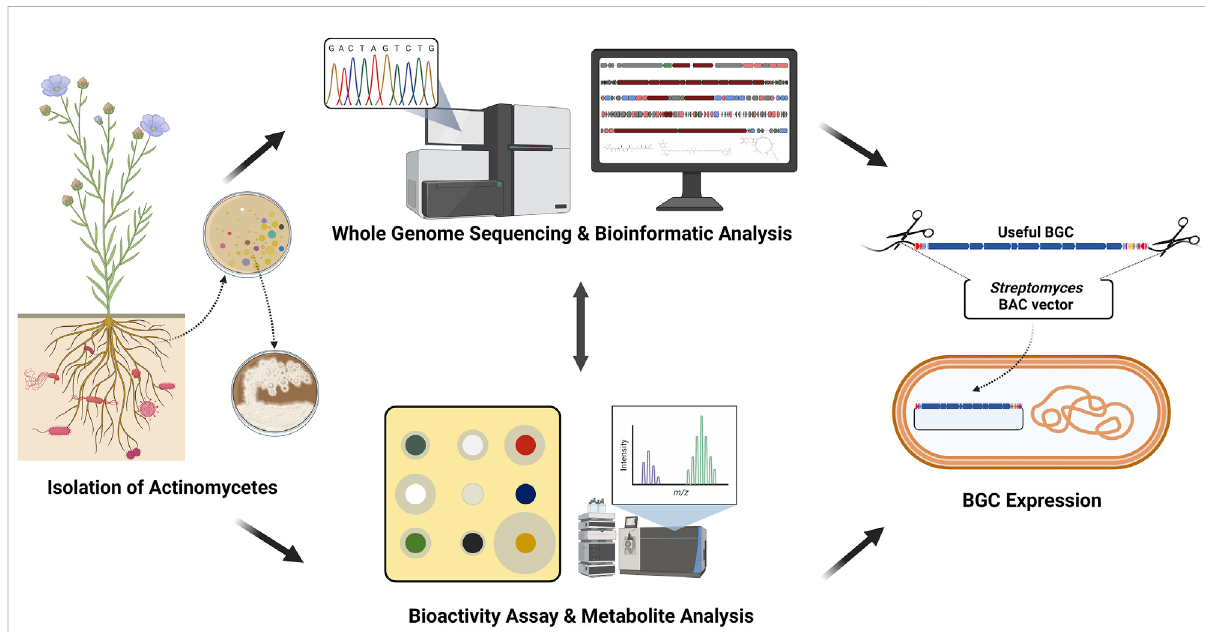
FIGURE 1 Actinomycetes-based genome mining scheme. First,actinomycetes were isolatedfrom the soil. The isolated actinomycetes were analyzed for the whole genome sequence and metabolites. Finally, valuable biosynthetic gene clusters (BGCs) were isolated and expressed (Created with